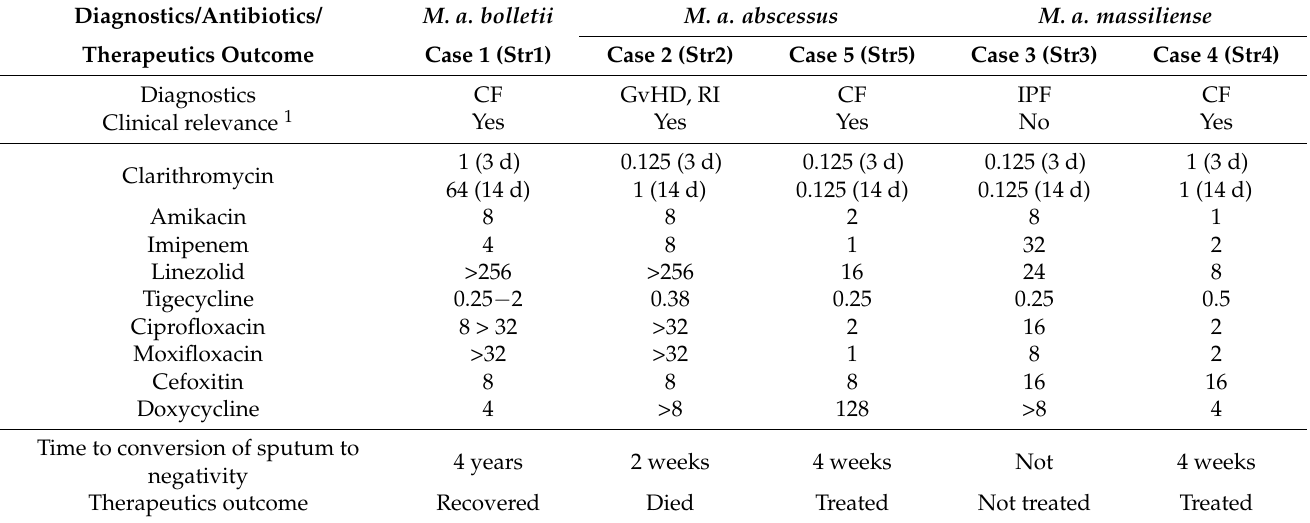
Table 1. Susceptibility to antibiotics and clinical relevance of Mycobacterium abscessus strains.